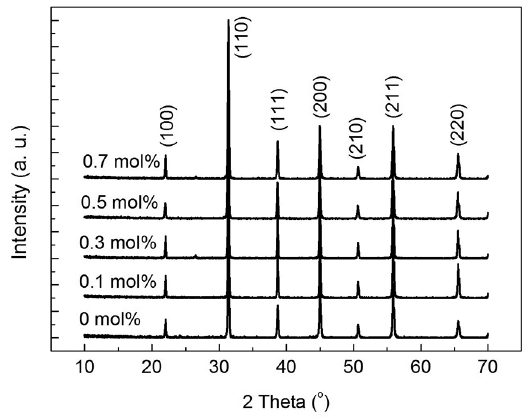
Figure 1: XRD patterns of BZT10 + x Yb